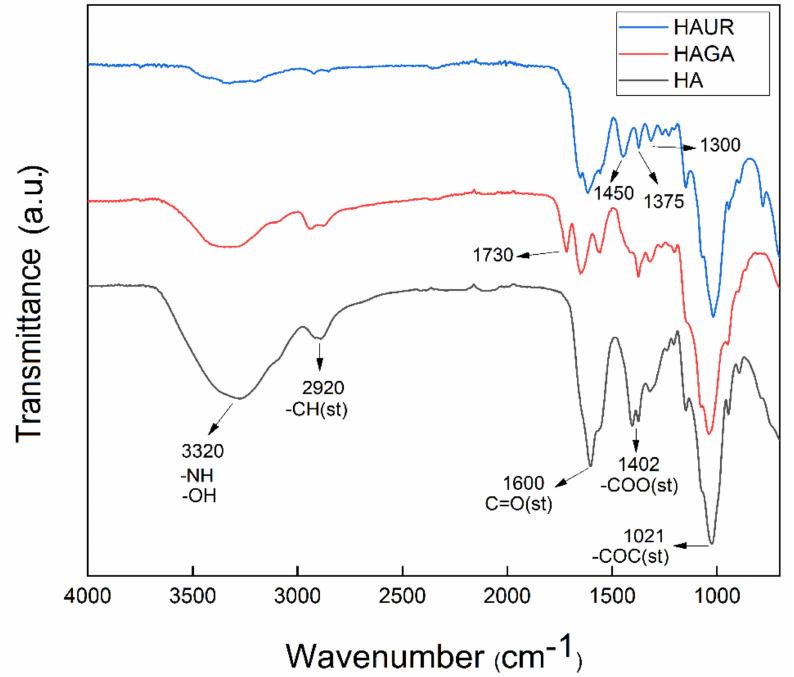
Figure 4. FTIR spectra of microparticles formed from native (HA) and crosslinked (HAGA and HAUR)